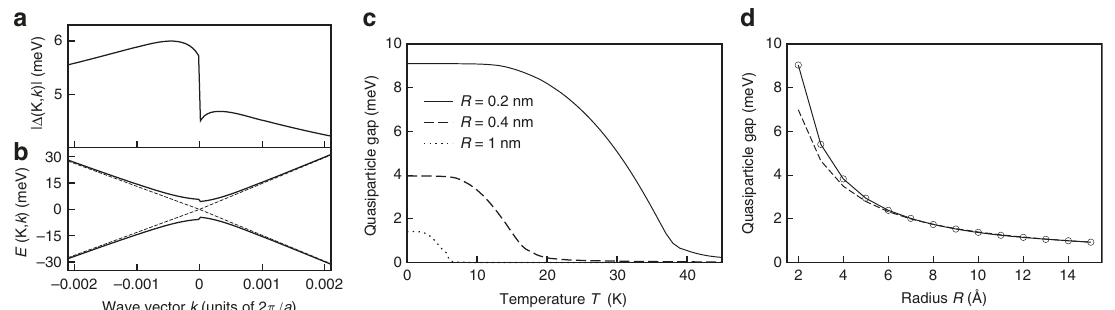
Fig. 5 Excitonic insulator behavior from mean- fi eld theory. a Excitonic order parameter, Δ ð τ ¼ K ; k Þj j , vs momentum k within K valley and b corresponding quasiparticle dispersion, E (K, k ), for the (3, 3) armchair carbon nanotube. The data are derived by solving self-consistently the gap equation. For comparison, the noninteracting bands are indicated (dashed lines). The band in the K ′ valley is obtained by time reversal, as Δ ð K 0 ; k Þj j ¼ Δ ð K ; (cid:2) k Þj j . c Quasiparticle gap vs temperature T for different radii [for the (3, 3) tube R = 2 Å]. d Quasiparticle gap vs R . The dashed curve is a fi t proportional to 1/ R pointing to the scaling behavior at large R